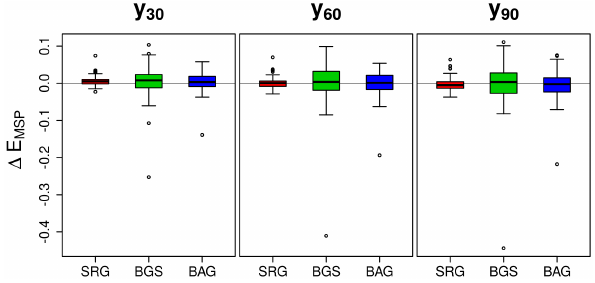
Figure 3. E MSP estimates of LOO (in case of SRG and BGS) and OOB (in case of BAG) subtracted from E MSP estimates of the outer cross-validation for all catchments and predictands; n =